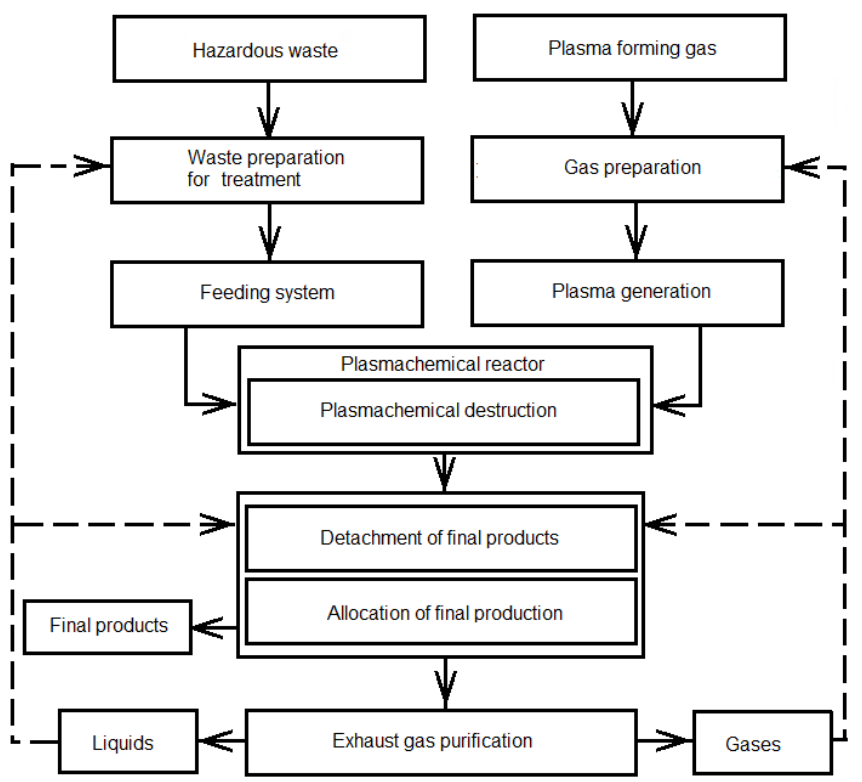
Figure 1. The diagram of plasma-chemical waste decomposition.